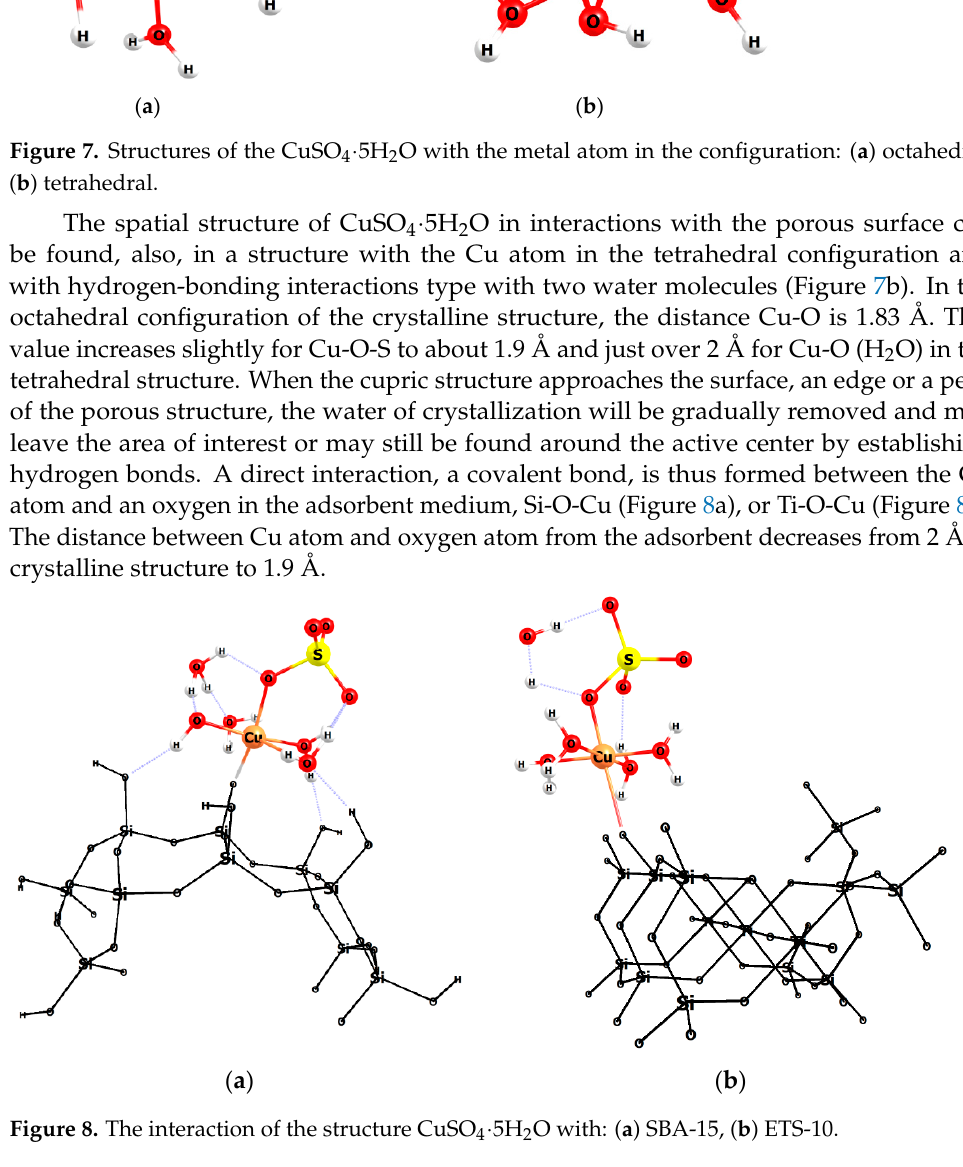
( b ) Figure 9. The configuration of Cu atom in interactions with porous surface: ( a ) square planar; ( b ) tetrahedral.